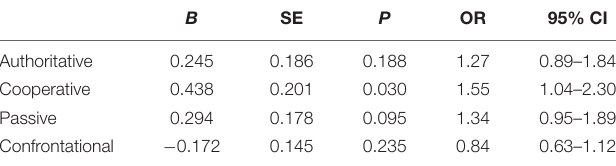
TABLE 3 | Adaptive interviewing (case strength).